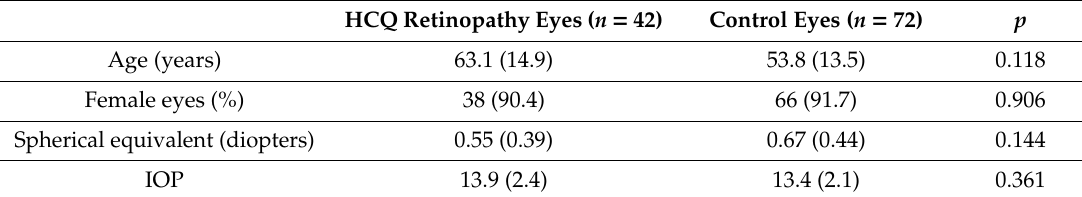
Table 1. Demographic and clinical participants’ characteristics of hydroxychloroquine (HCQ) retinopathy eyes and control eyes (114 eyes of 76 individuals). Data for quantitative variables are shown as mean (standard deviation). Intraocular pressure (IOP). Analysis was performed using the Mann–Whitney test.